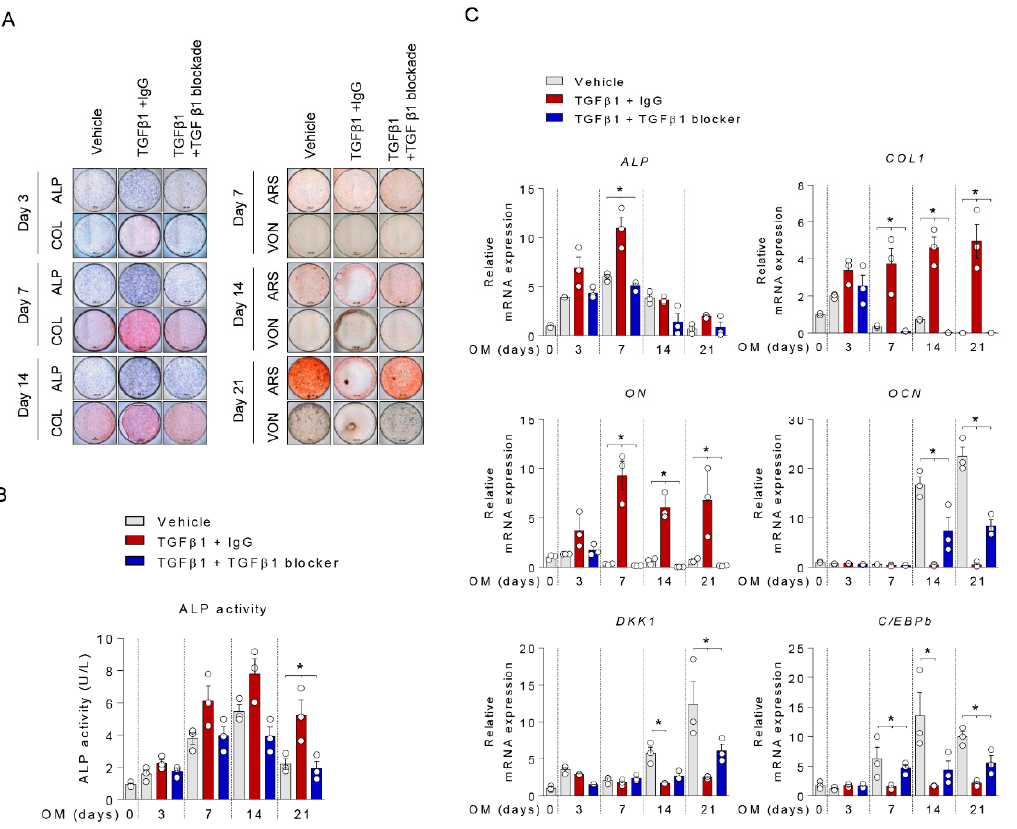
Figure 3. Anti-TGF β 1 antibody blocked the suppressive effect of TGF β 1 on mineralization. Osteoprogenitors were differentiated into osteoblasts in the presence of 10 ng/mL TGF β 1 and Anti-TGF β 1 anbituo for the indicated days and analyzed by ( A ) ALP, COL, ARS, and von Kossa staining; scale bar is 200 μ m, ( B ) intracellular ALP activity, and ( C ) the mRNA levels for the osteogenic differentiation-related factors ( n = 3). All images of ( A ) are representative from the three independent experiments. Values are expressed as the mean ± SD. * p < 0.05.